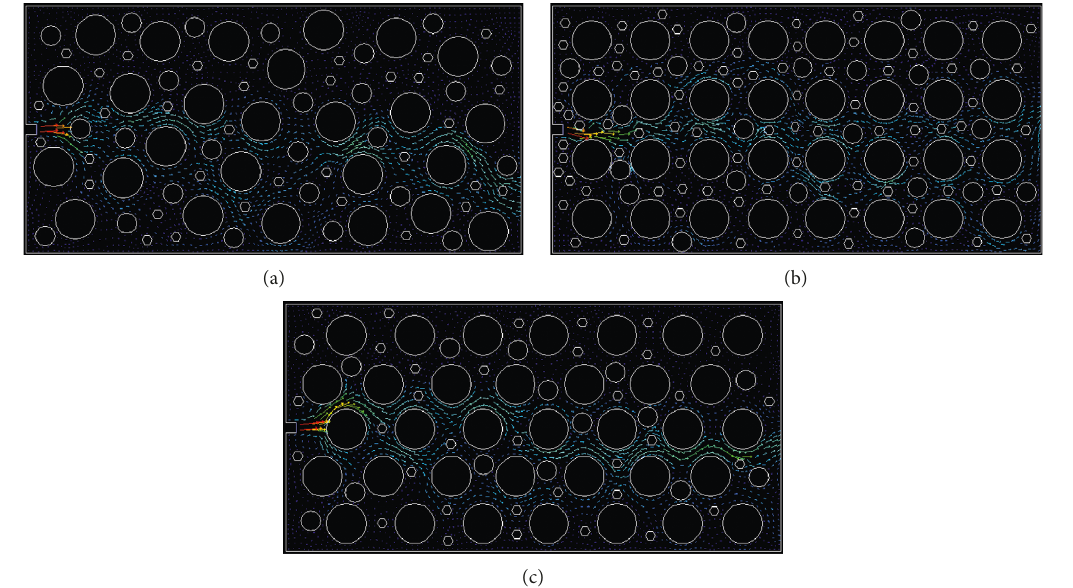
Figure 4: Velocity vector distribution of the water phase in each filling structure. (a) Structure 1. (b) Structure 2. (c) Structure 3.